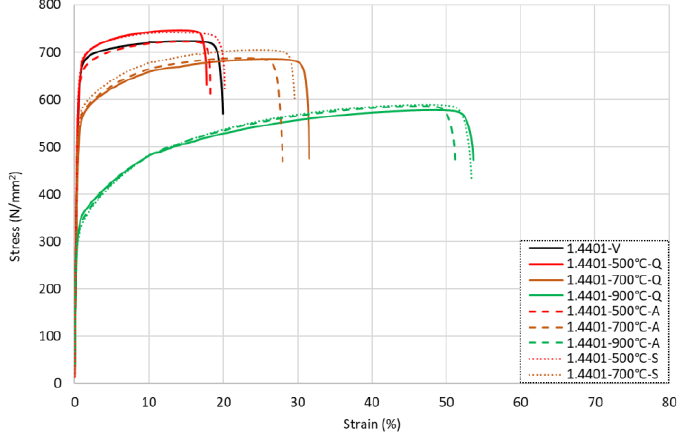
Figure 7. Stress – strain responses for grade 1.4401 stainless steel rebars following exposure to 500 °C, 700 °C, and 900 °C with various cooling methods.